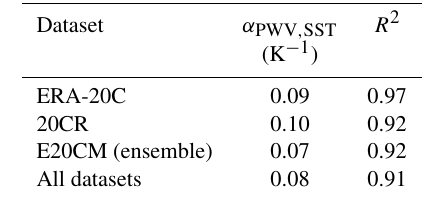
Table 1. Linear regression coefficient α W , SST estimated from (cid:49) PWV / PWV c against (cid:49) SST at 2-year resolution, assuming a re- lationship as given by Eq. (1). The respective coefficient of determi- nation is also provided. The α W , SST values are computed for ERA- 20C, 20CR, and for the ensemble of ERA-20CM simulations. Addi- tionally, the coefficient is estimated by pooling together ERA-20C, ERA-20CM (ensemble), and 20CR datasets.